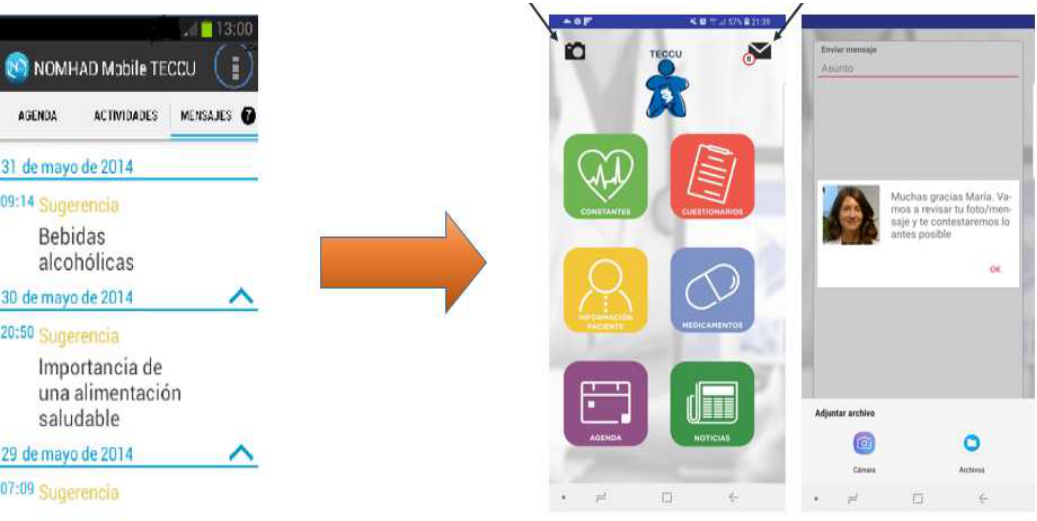
Figure 4. Adaptations to the communication process in the TECCU app.